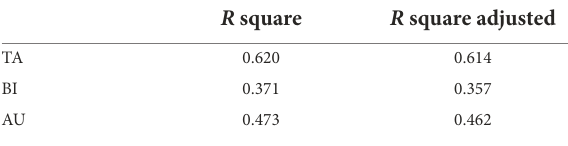
TABLE 7 The squared multiple correlations R 2